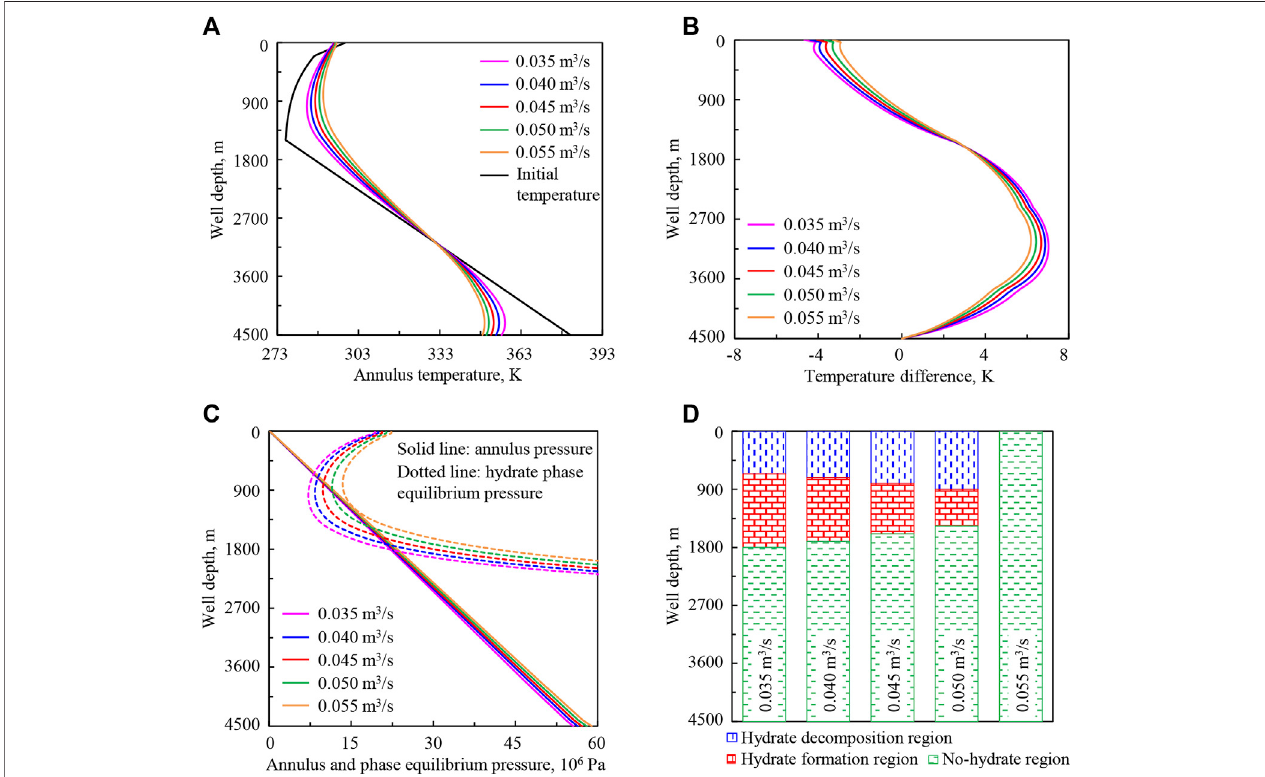
FIGURE 7 | Variation regularities of wellbore temperature fi eld, pressure fi eld, and hydrate formation region in deep-water drilling under different displacements of drilling fl uid: (A) annulus temperature, (B) temperature difference between the drilling fl uid in annulus and in drill string, (C) annulus pressure and phase equilibrium pressure, (D) hydrate formation